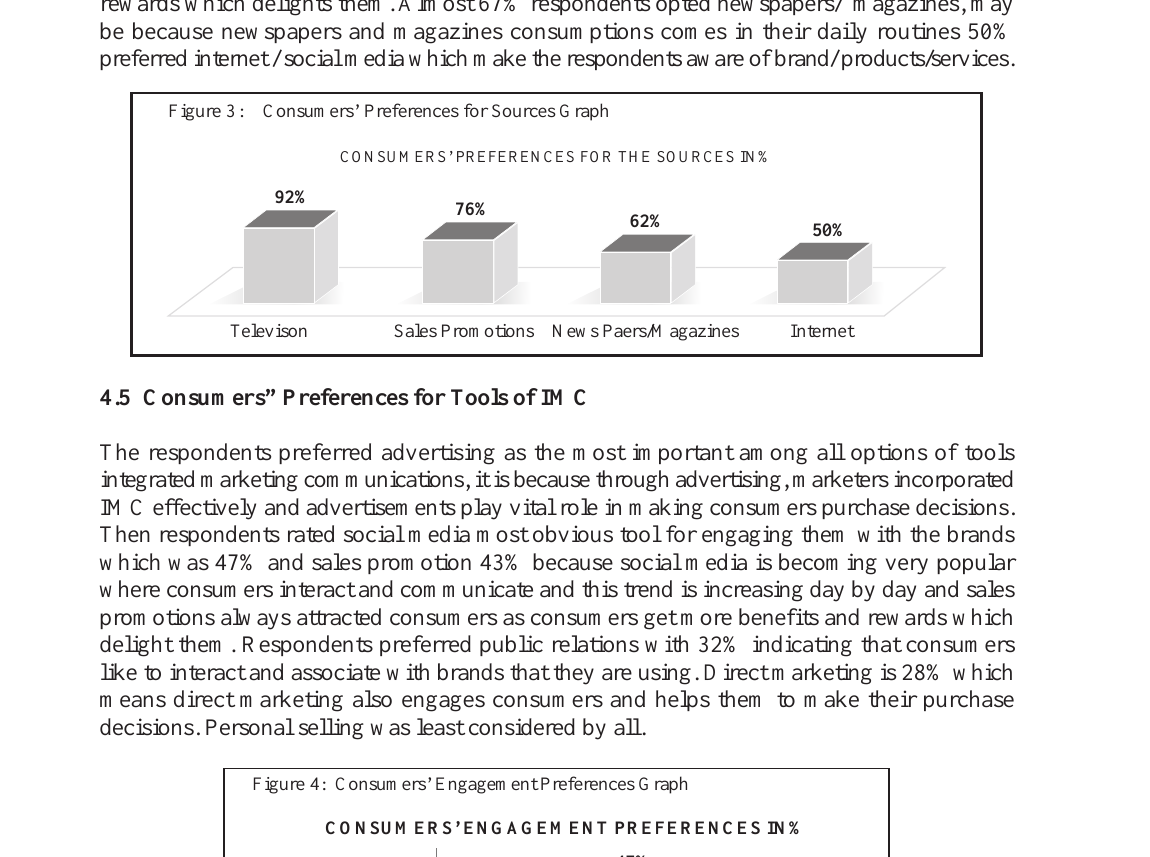
Figure 4: Consumers’ Engagement Preferences